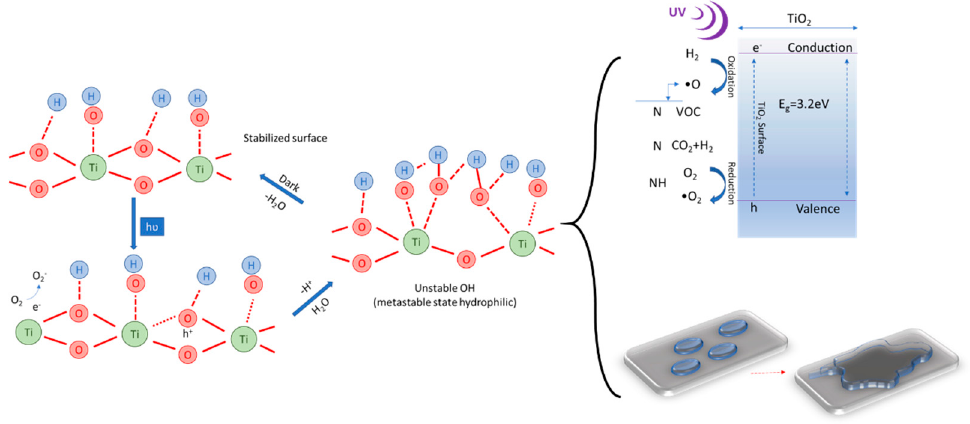
Figure 2. Schematic representation of the surface photoactivation with the change in the number of hydroxyl groups under the action of UV rays and, consequently, the induction of the two mechanisms that contribute to the self-cleaning capacity.